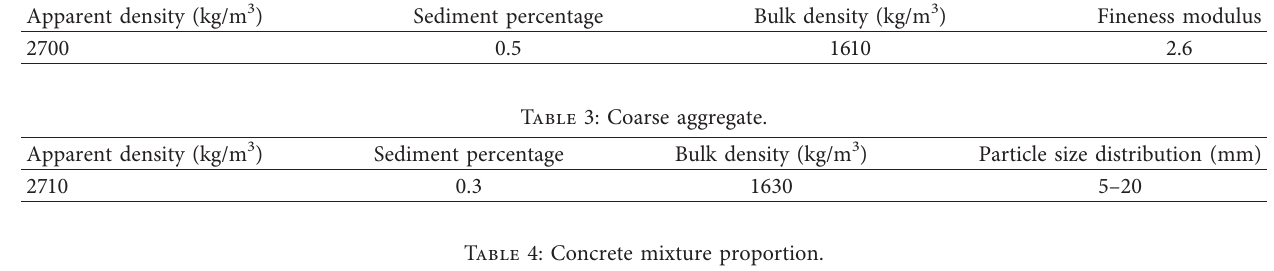
Table 2: Machine-made sand.